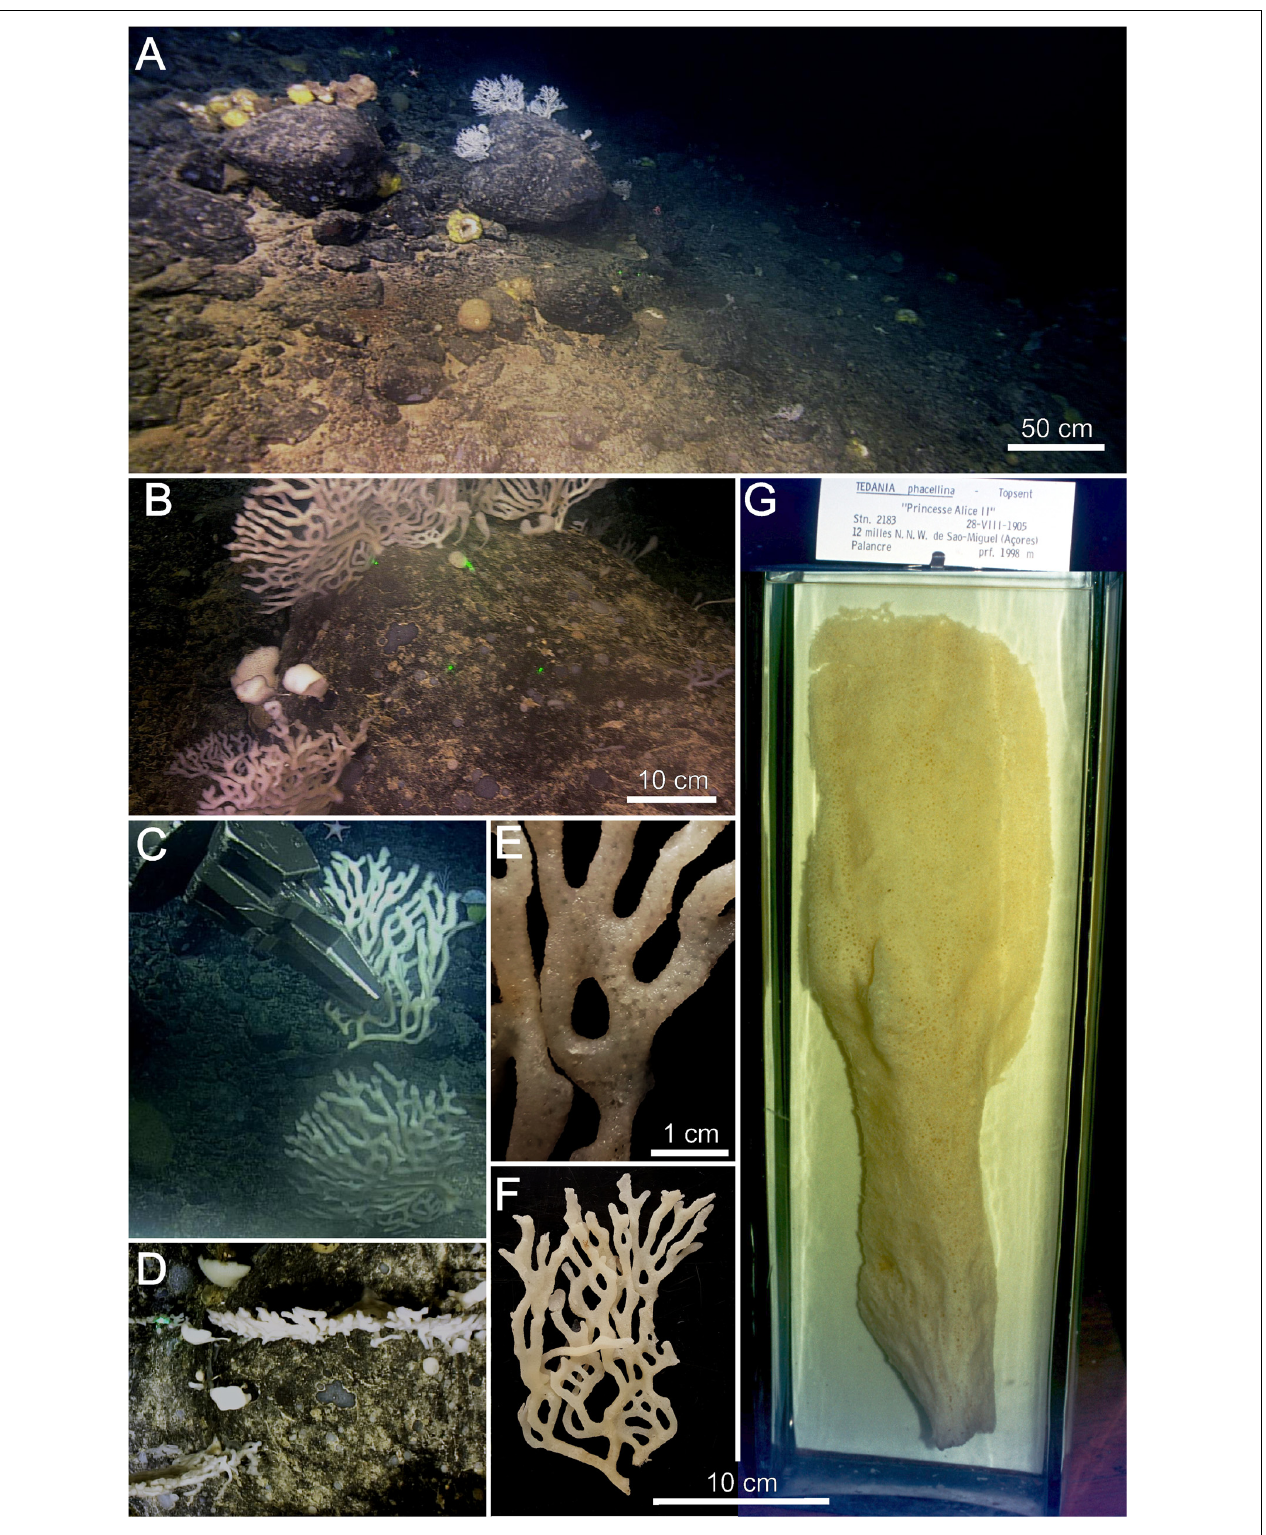
FIGURE 2 | Tedania ( Tedaniopsis ) rappi sp. nov. (A,B) Environment of holotype. (C) In situ collection of holotype. (D) View of two specimens from the downward facing camera. (E) Detail of the surface of the holotype on which the oscula are seen. (F) Holotype. (G) Tedania ( Tedaniopsis ) phacellina , Topsent’s holotype located in the display cases of the Oceanographic Museum of Monaco. Note that figures (F,G) are on the same scale to compare the proportions and shapes of both species.